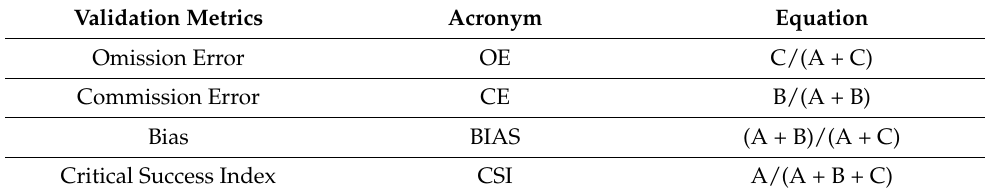
Table 5. Validation metrics, acronyms, and equations derived from the contingency table described in Table